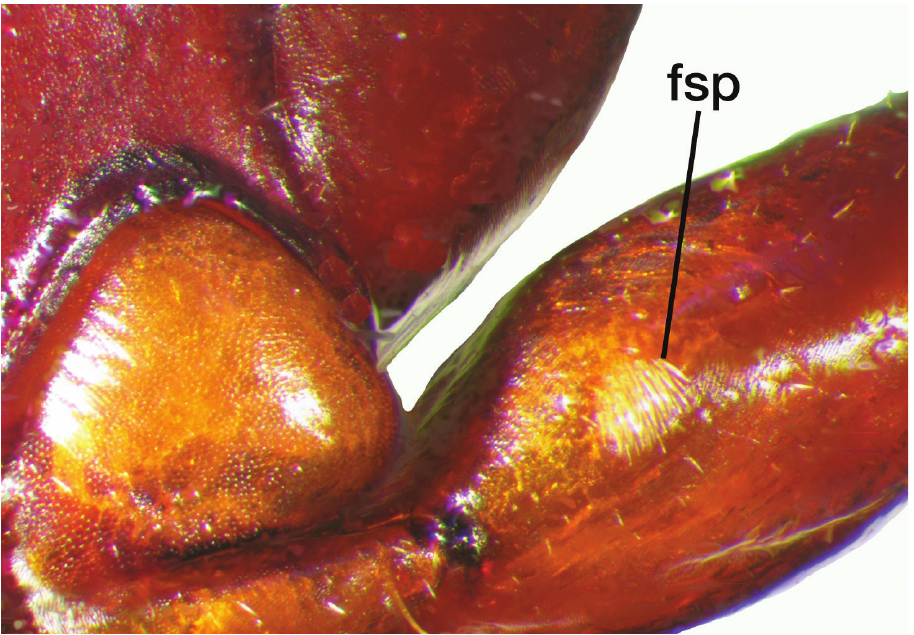
Figure 91. Digital image showing the patch of short dense seta present near the base of the fore-femur, ventral surface, of males of Miscelus javanus Klug. Legend: fsp femoral setae patch. 1.72 mm; width: head 1.64 – 2.52, pronotum 2.14 – 2.68, elytra 2.83 – 3.00, me- tepisternum 0.68 – 0.84 mm. Body proportions . HW/HL 2.05 – 2.86; PWM/PL 1.26 – 1.44; EL/EW 1.55 – 1.87; ML/MW 1.89 – 2.05. Color . Fig. 90. Dorsum of head brunneous to rufo-piceous, clypeus brunneous to rufo-piceous, slightly lighter than head, labrum brunneous, slightly lighter than clypeus; antennae and palpi brunneous to rufo-brunneous; pronotum brunneous to rufo-piceous, slightly iridescent; elytral disc rufo-brunneous to rufo-piceous, dark, with testaceous macula, centrally in apical 1/3, from suture to interval 5, ovoid in ap- pearance; ventral surface rufous to brunneo-testaceous; legs brunneo-testaceous, tibia brunneous to rufo-piceous,